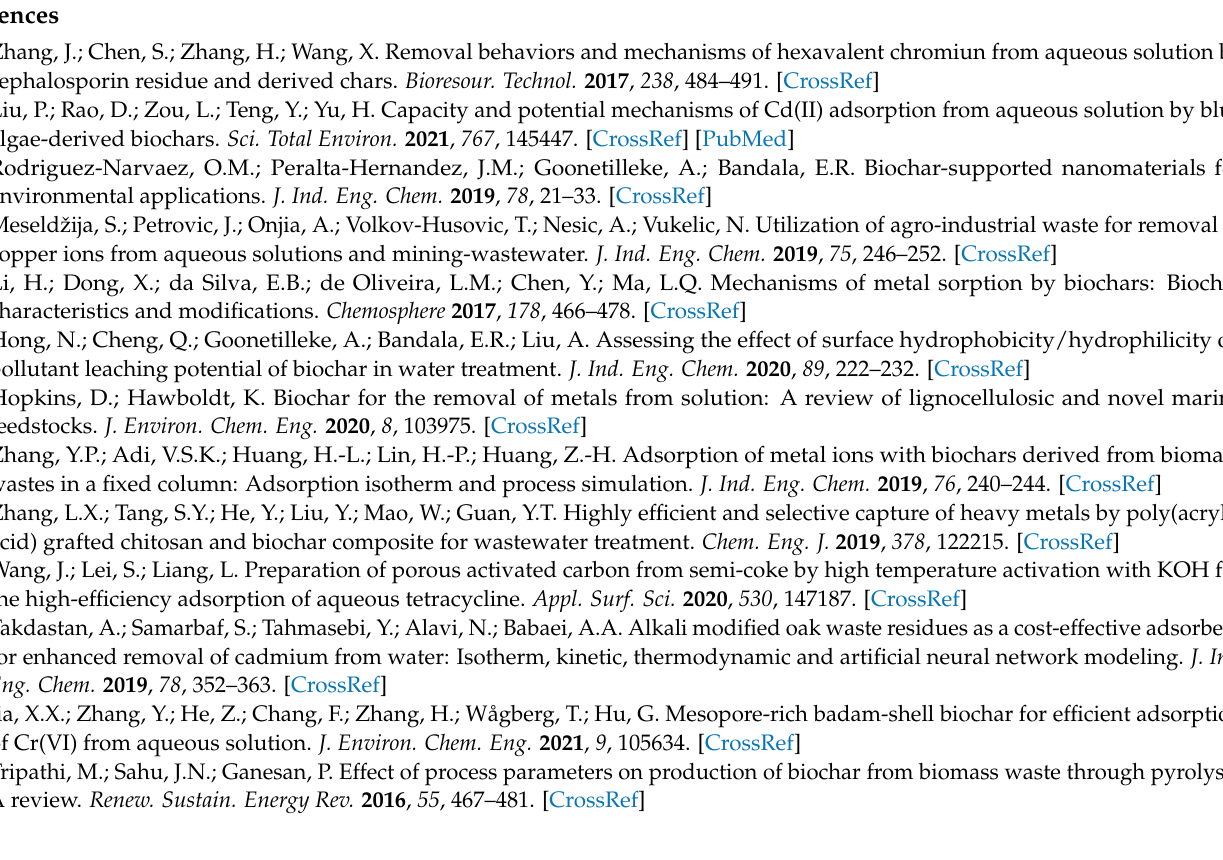
Figure S4 SEM images of HSC-MA-1, HSC-MA-2, HSC-MA-3; Figure S5 detailed XPS analysis on